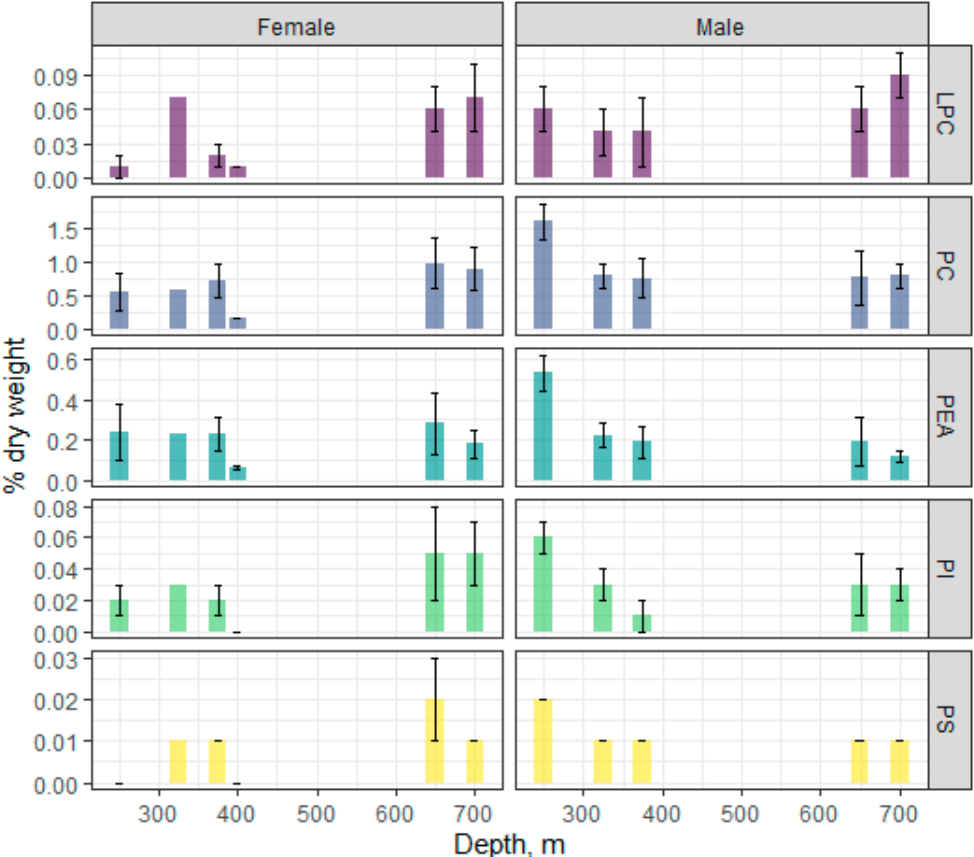
Figure 4. Changes in the content of individual phospholipid classes in males and females of the beaked redfish, Sebastes mentella, in the depth gradient of the Irminger Sea (North Atlantic). The random forest algorithm applied to individual PL classes revealed two classifi- 231 ers that defined the sample grouping and distribution—PEA and LPC. 232 2.4. Species-Specific Characteristics of the Fatty Acid Spectrum in Beaked Redfish, Its Sex 233 Specificity, and Change Depth-Wise.